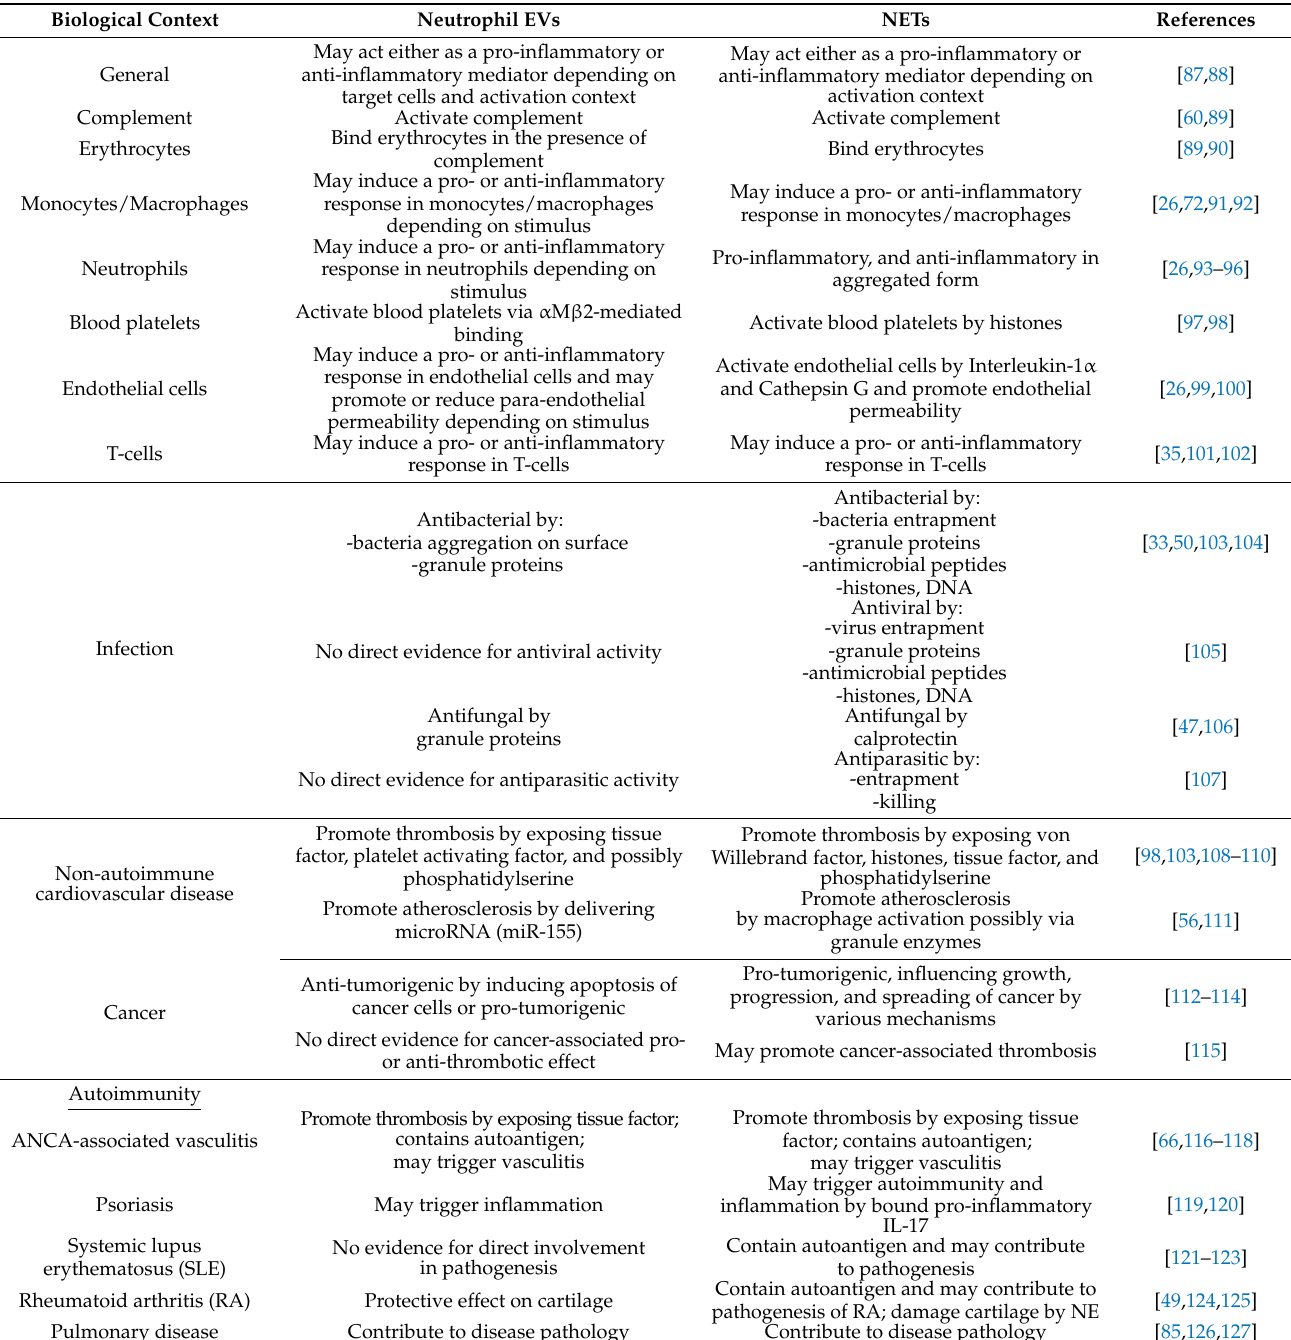
Table 2. Overlapping and opposing effects of neutrophil-derived extracellular vesicles and NETs in health and disease. NETs and extracellular vesicles trigger a large variety of secondary effector mechanisms that are not entirely included in this